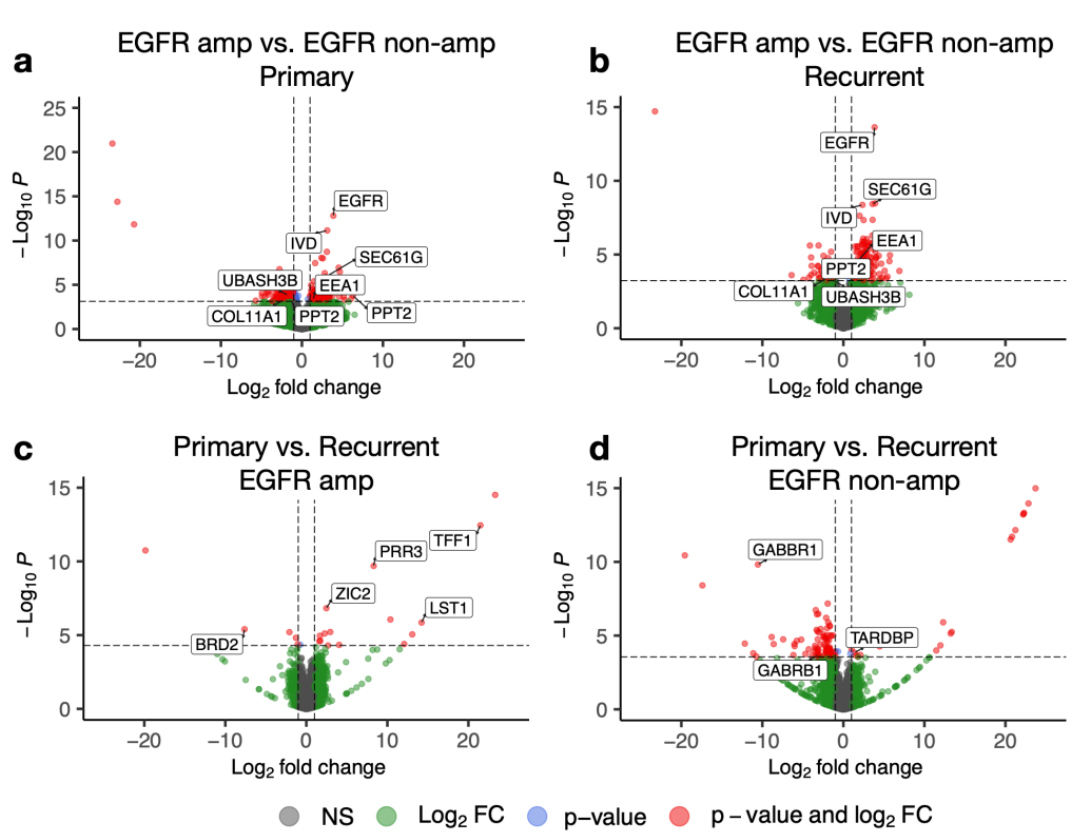
Figure 3. Volcano plots for differential gene expression for patient subgroups with key genes labelled. ( a ) Differential gene expression depicted for EGFR-amplified versus EGFR non-amplified primary tumours. ( b ) Differential gene expression depicted for EGFR-amplified versus EGFR non-amplified recurrent tumours. ( c ) Differential gene expression depicted for primary versus recurrent EGFR-amplified tumours. ( d ) Differential gene expression depicted for primary versus recurrent EGFR non-amplified tumours.